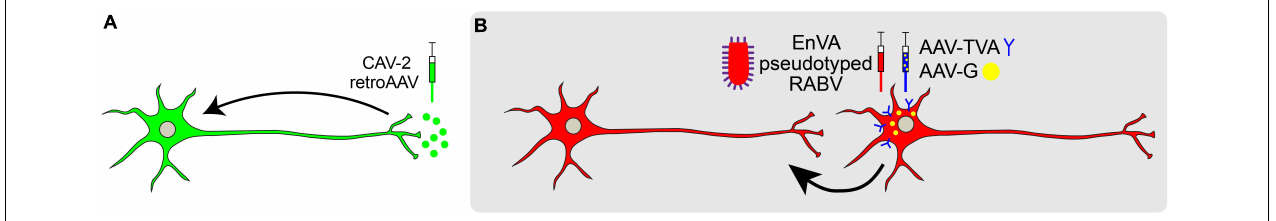
FIGURE 3 | Retrograde viral tracing strategies. (A) Non-transsynaptic retrograde tracing using retro-AAV or CAV-2. (B) Transsynaptic retrograde tracing using pseudotyped rabies virus is used to trace monosynaptic connections. Rabies G (RB) is provided in trans and neurons are pseudotyped with TVA receptor to endow cell-type specificity. Once a neuron expressing TVA and RG is infected with RABV expressing EnvA, the RABV may jump across one synapse in a retrograde